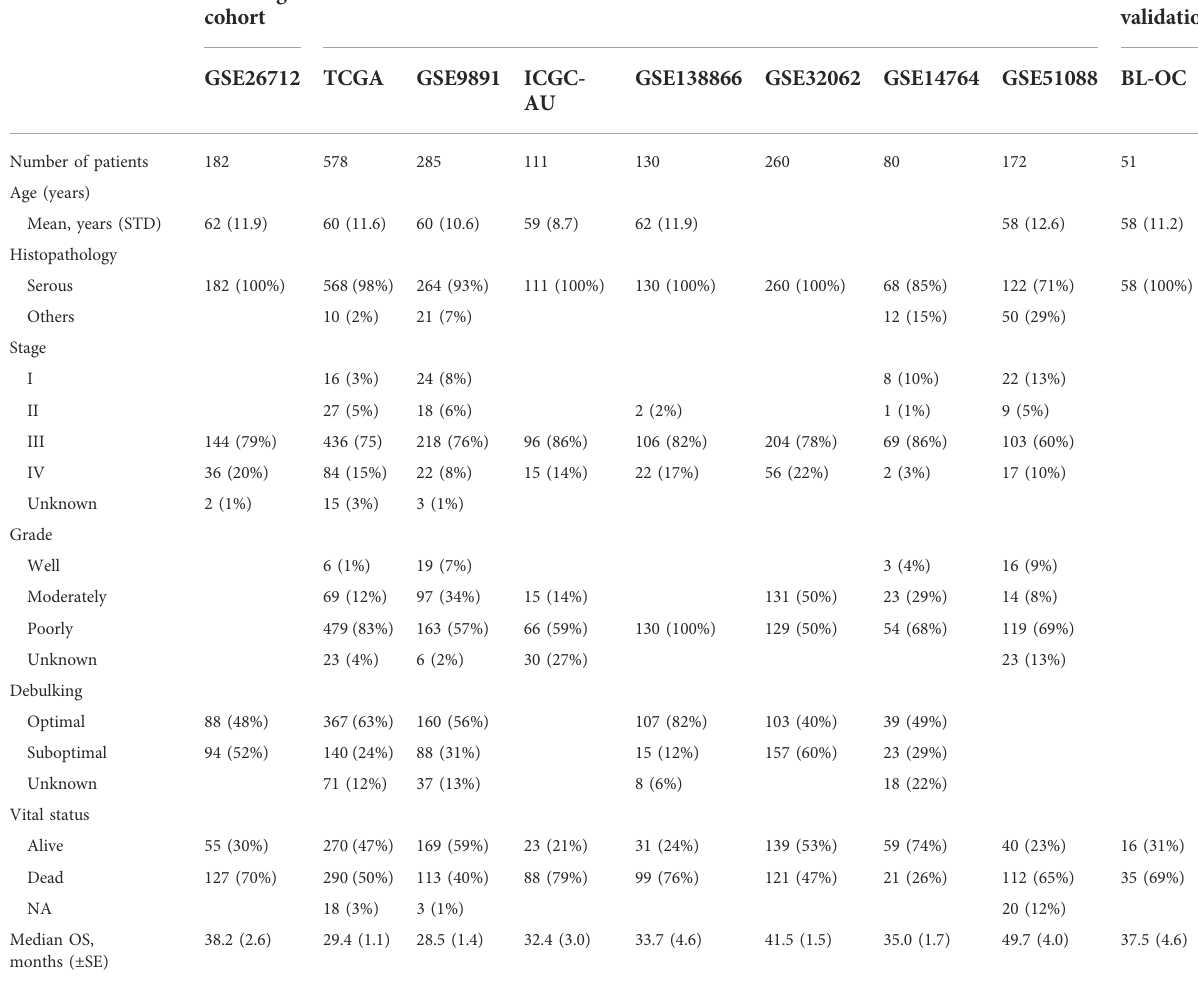
TABLE 1 Overview of the clinical and pathologic characteristics of all the